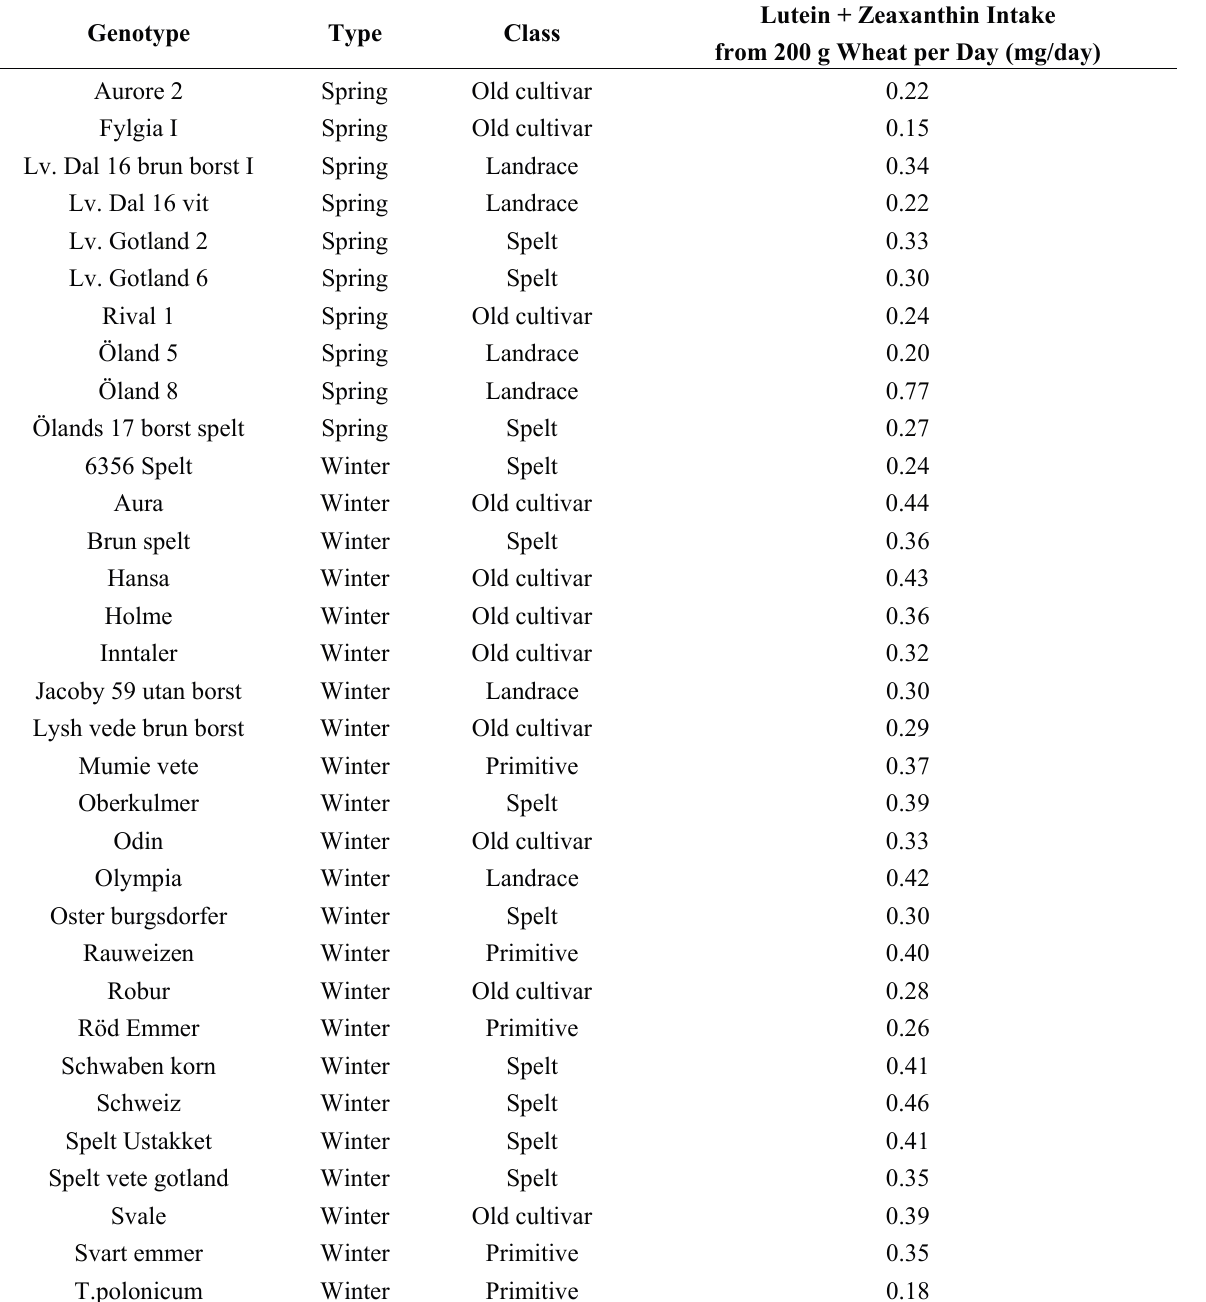
Table 4. Intake per day of lutein+zeaxanthin from an average consumption of 200 g wheat per day.